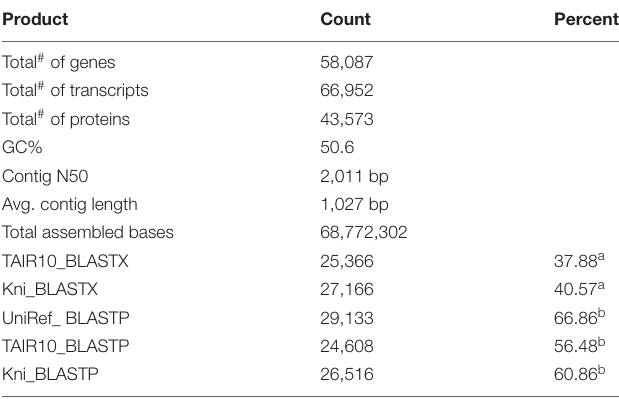
TABLE 1 | Summary of UTEX 1559 RNA-Seq assembly and